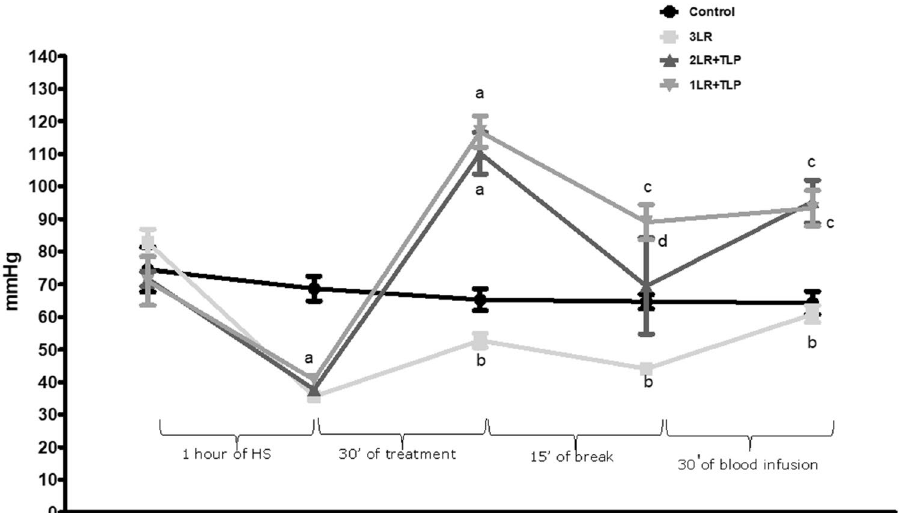
Figure 2. Mean arterial pressure during the experiment. a P < 0.001 vs. control; b P < 0.001 vs. 2LR + TLP and 1LR + TLP; c P < 0.01 vs. control; d P < 0.05 vs. control; HS, hemorrhagic shock; Control, no intervention; 3LR, induction of HS, followed by infusion of lactated Ringer’s at 3 times the volume of the blood withdrawn; 2LR + TLP, induction of HS, followed by infusion of lactated Ringer’s at 2 times the volume of the blood withdrawn, together with intravenous injection of terlipressin at 10 µg/100 g body weight; 1LR + TLP, induction of HS, followed by infusion of lactated Ringer’s at a volume equal to that of the blood withdrawn, together with intravenous injection of terlipressin at 10 µg/100 g body